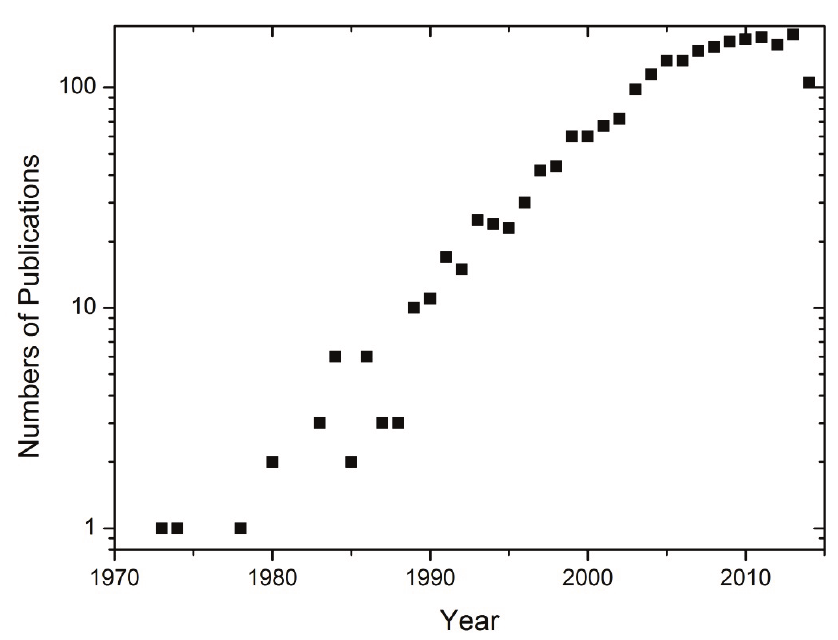
Figure 2. Number of papers published per